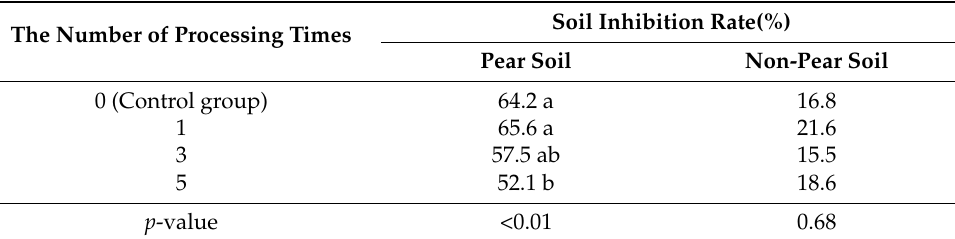
Table 1. Effect of water treatment on the inhibition rate of the pear soil. The Number of Processing